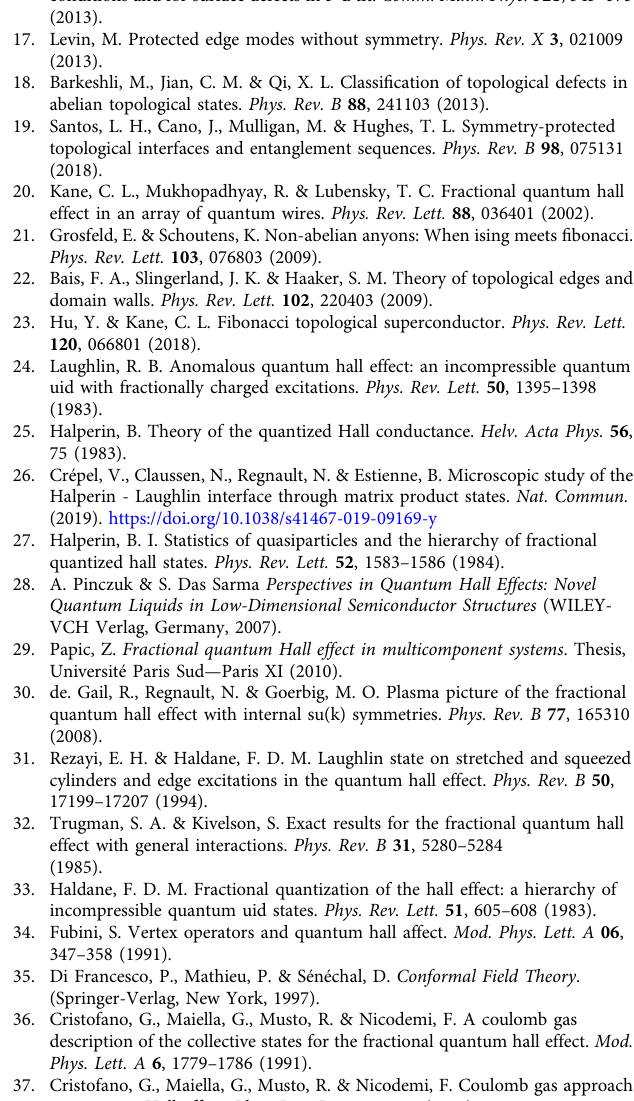
Data availability